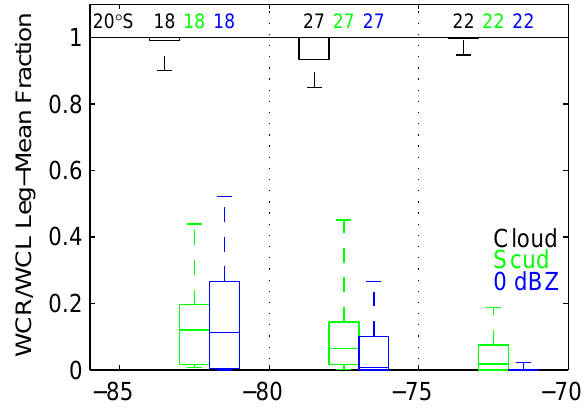
Fig. 14. Boxplots of frequency of cloud, “scud” (cloud with a base more than 100m below the median), and heavy cloud-base drizzle (WCR column-maximum radar reflectivity > 0dBZ), from 20 ◦ S C130 subcloud